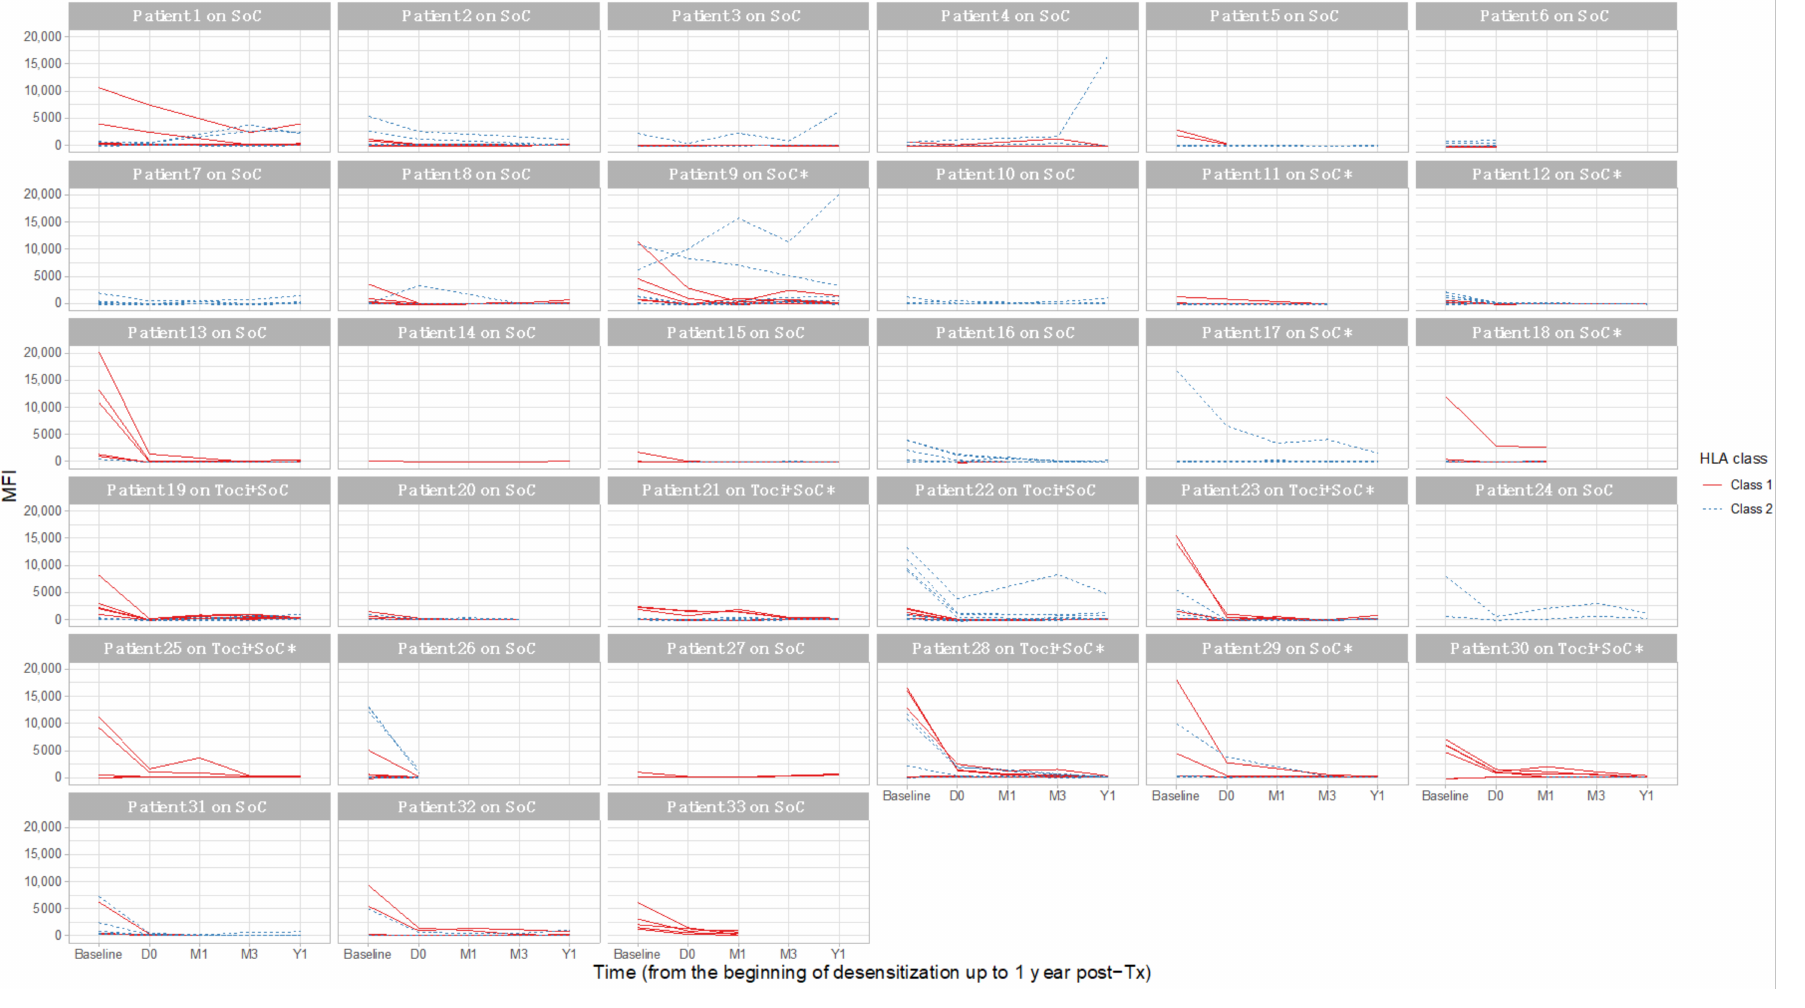
Figure 5. Evolution of donor-specific antibodies after transplantation, depending on the desensitization treatment. Toci + SoC: Tocilizumab + standard of care; SoC: standard of care only. A star indicates a BPAR episode in the 1st year